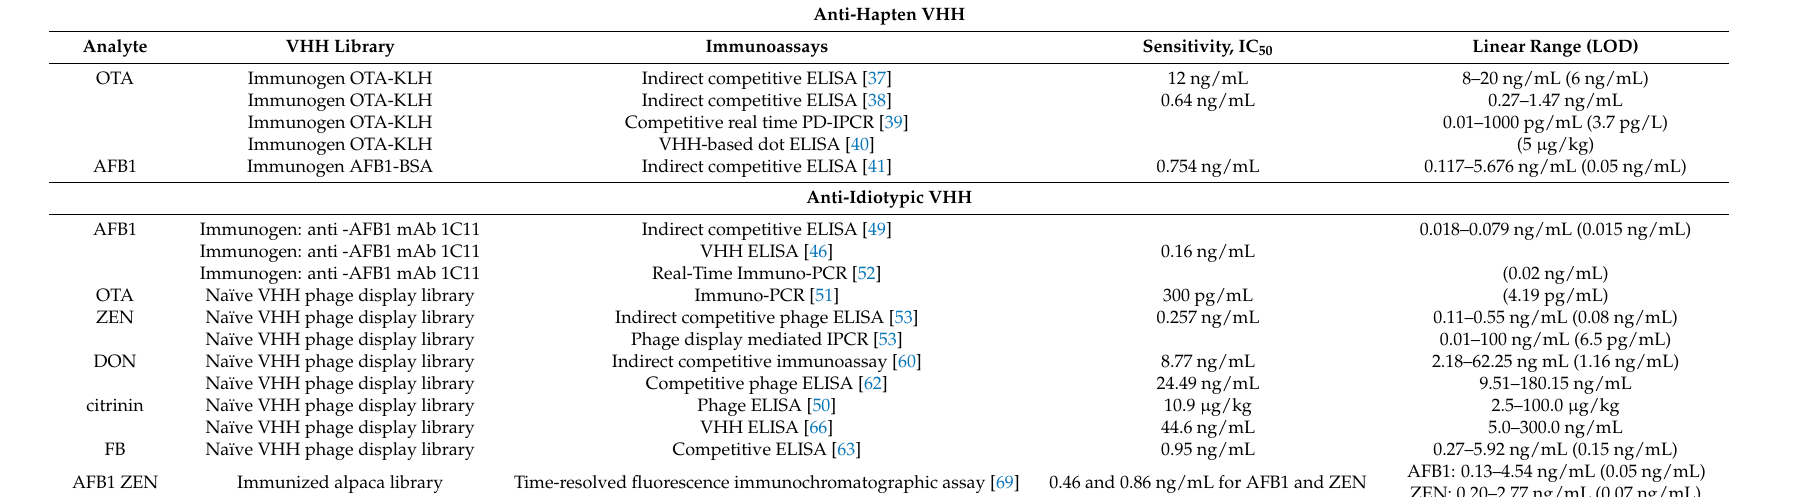
Table 1. VHH generation and applications for mycotoxin